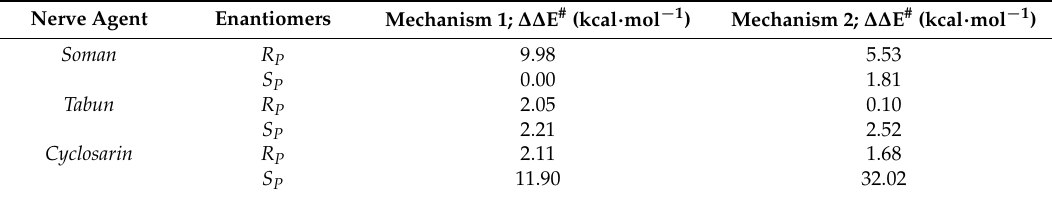
Table 3. Relative activation energy ( ∆∆ E # ) in the hydrolysis mechanism of different nerve agents by the wild-type DFPase (units were kept in kcal.mol − 1 for ease of comparison with docking results). Nerve